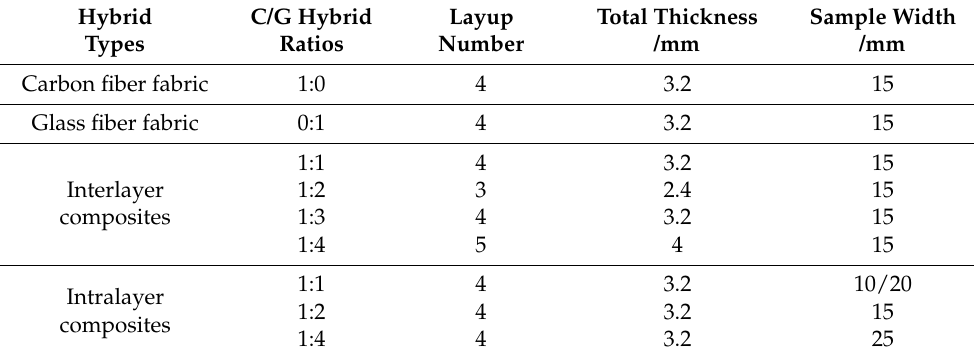
Table 5. Parameters of testing samples of hybrid composites.